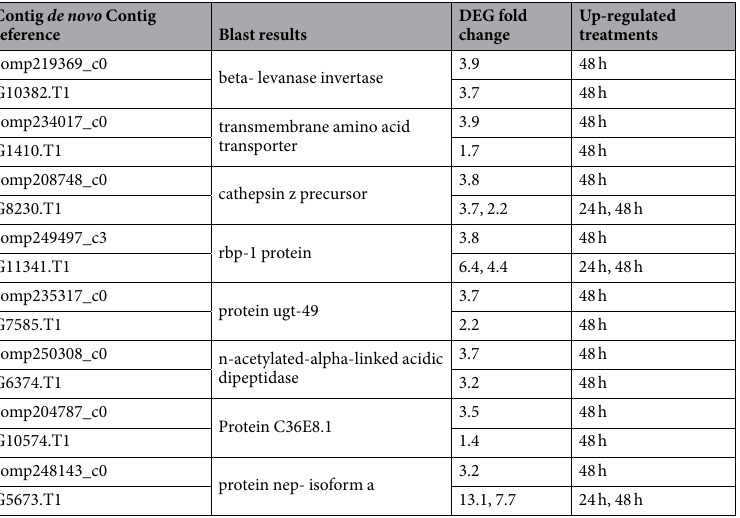
Table 3. Differentially expressed genes (DEGs, P < 0.05, FDR < 0.1) up-regulated after hatching 8 h, 24 h or 48 h exposure to potato root diffusate common to G . rostochiensis de novo and reference